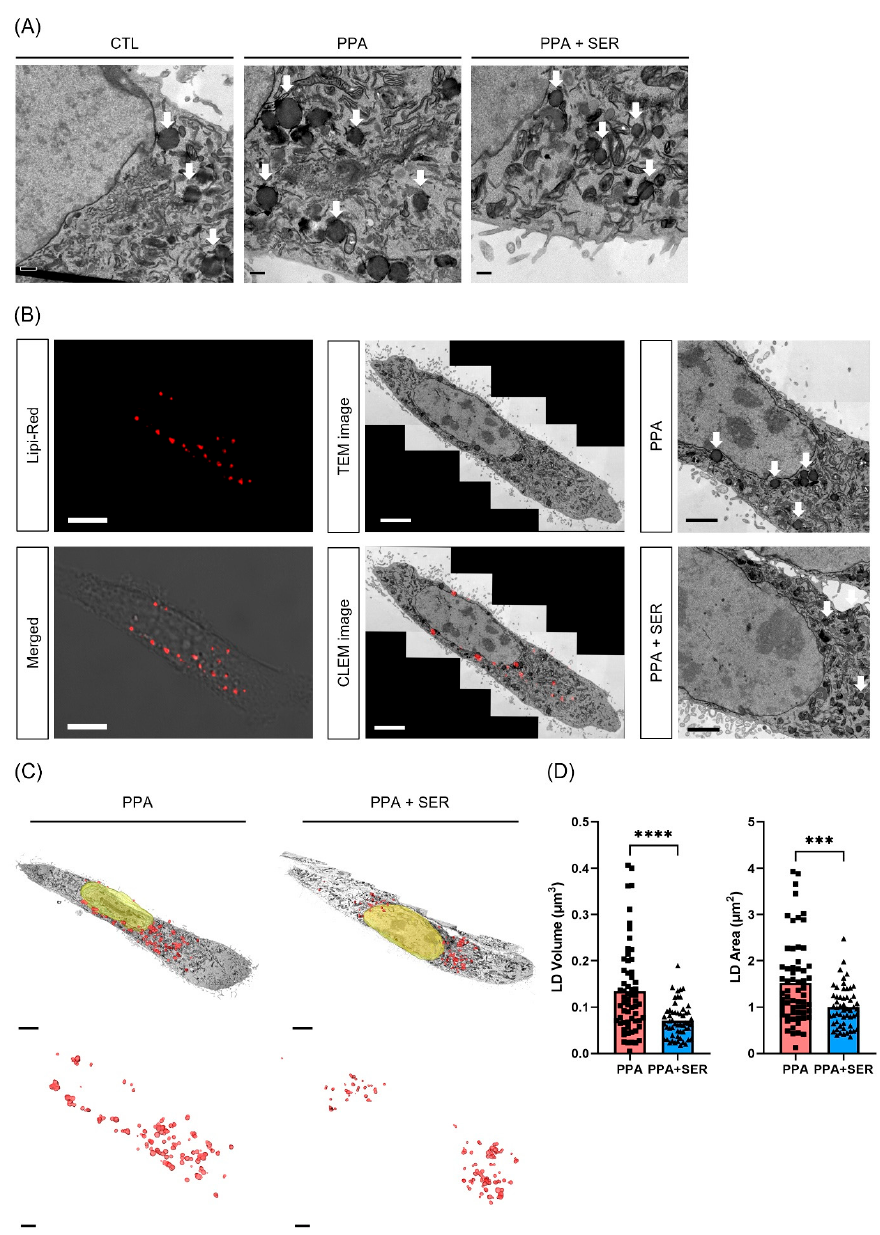
Figure 4. Three-dimensional volume reconstruction of lipid droplets (LD) shows a different size in PPA-treated HT22 cells. Cells were treated with 5 mM PPA only or 5 mM PPA with 10 mM L-serine (SER) for 48 h. ( A ) Representative electron microscopic images of HT22 cells. TEM images showed the increased size of lipid droplets in PPA-treated HT22 cells. White arrows represent lipid droplets (LD). Scale bar, 1 µ m. ( B ) Representative CLEM images of lipid droplets (LD) in PPA-treated HT22 cells. The location of the red signal under confocal microscopy was specifically in the abnormal lipid droplets (LD) under electron microscopy. Scale bar, 10 µ m (confocal image); 5 µ m (TEM image). ( C ) Representative 3D volume reconstruction of lipid droplets (LD) in HT22 cells. Scale bar, 4 µ m (top); 2 µ m (bottom, the magnified images). ( D ) Quantification of 3D volume and area of reconstructing lipid droplets (LD) in HT22 cells. *** p < 0.001, **** p < 0.0001 by unpaired two-samples t